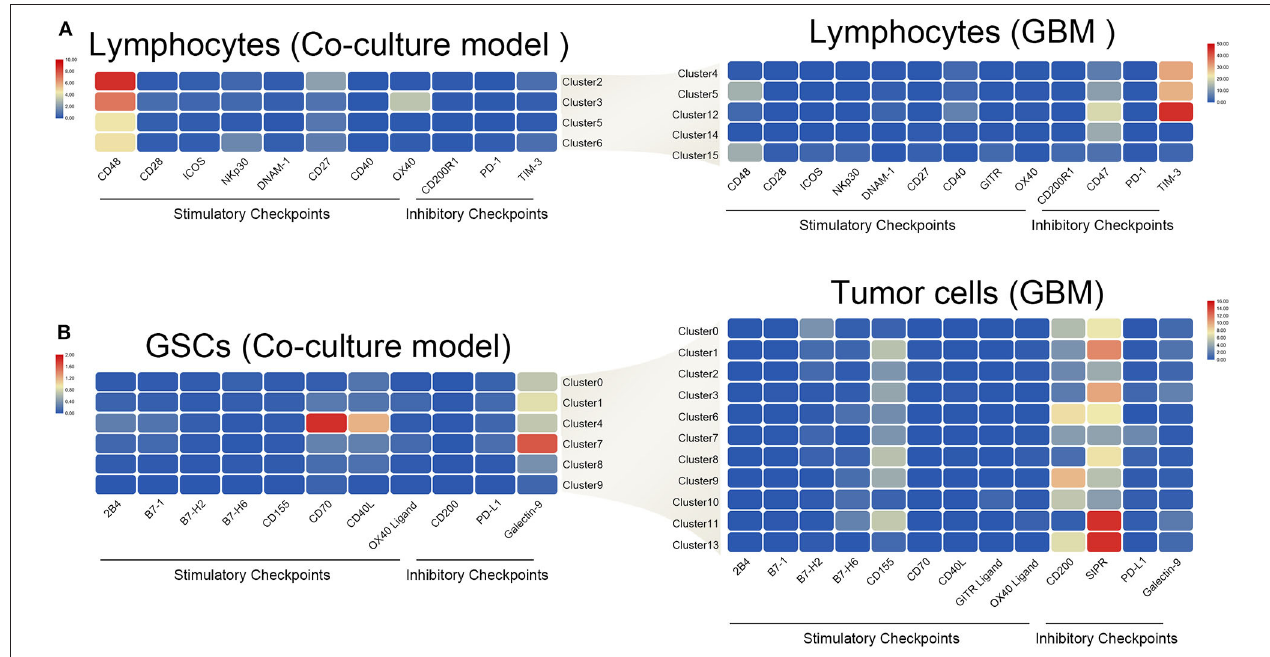
FIGURE 6 | Differences in the interaction pattern between tumor cells and immune cells in early and late stages of glioma. Changes in expression of immune checkpoints and the corresponding receptors in both immune cells (A) and glioma stem cells (B) , in the early and late stages of glioma.